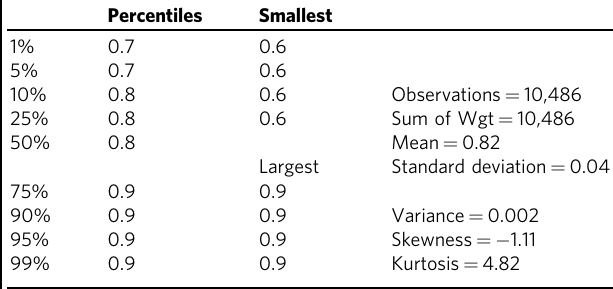
Table 4 Probit regression results of the Likelihood of enrollment on NHIS.